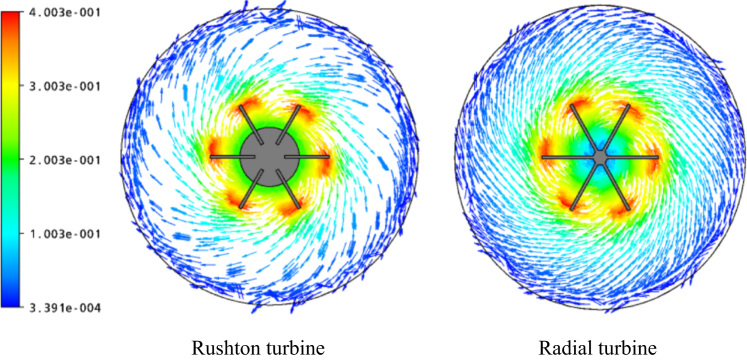
Velocity vectors for Re=3.1×104, at R*=0.